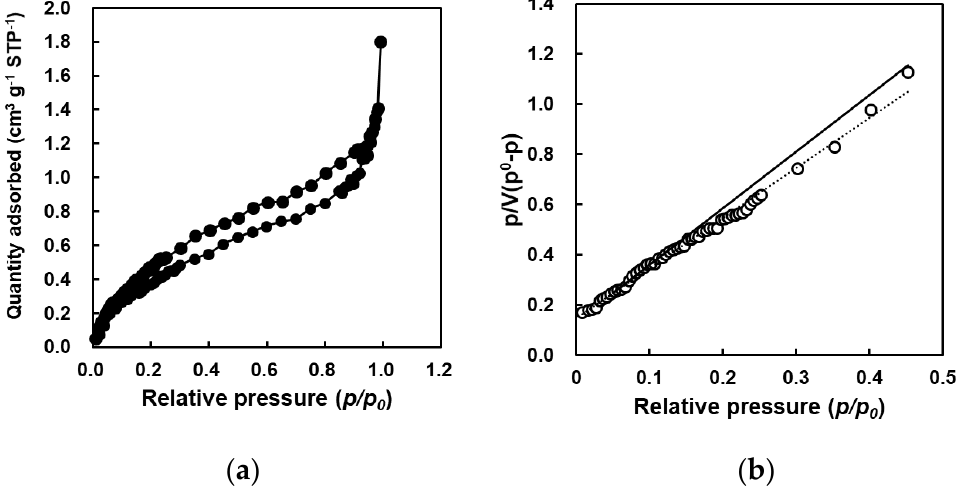
Figure 4. ( a ) N 2 adsorption − desorption isotherms of PSA nanofiber meshes; ( b ) Brunauer–Emmett–Teller (BET) plot of PSA nanofiber meshes.